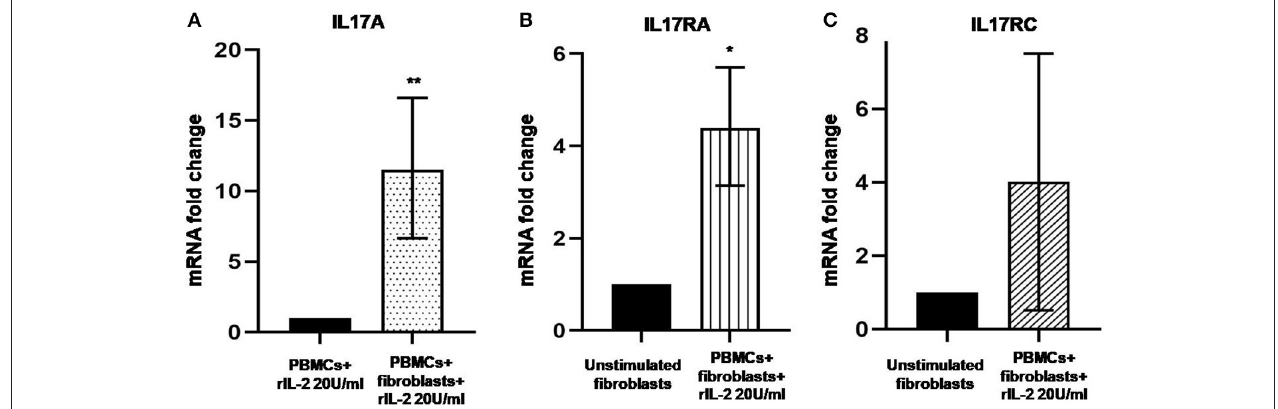
FIGURE 1 | Levels of IL17A , IL17RA , and IL17RC in co-cultured PBMCs and fibroblasts from early dcSSc patients. Results are fold changes in mRNA levels of target genes in real-time PCR. (A) Shows the expression of IL17A in PBMCs co-cultured with autologous skin fibroblasts and hrIL-2 20 U/ml as compared to PBMCs cultured in the presence of hrIL-2 20 U/ml only. (B) Shows the expression of IL-17RA in fibroblasts co-cultured with autologous PBMCs and hrIL-2 20 U/ml as compared to fibroblasts alone. (C) Shows the expression of IL-17RC in fibroblasts co-cultured with autologous PBMCs and hrIL-2 20 U/ml as compared to fibroblasts alone. Data are median and IQR ranges, Wilcoxon signed rank test in panels (A,B) . Data are mean and SD, one sample t -test in panel (C) because of normal data distribution. * p < 0.05; ** p < 0.01; number of samples per group =